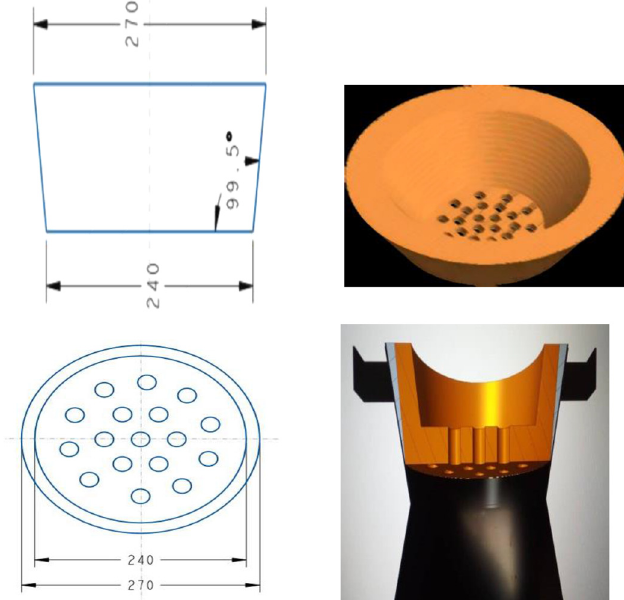
Fig. 1. Engineering drawing and pictorial view of a ceramic liner and clean biomass